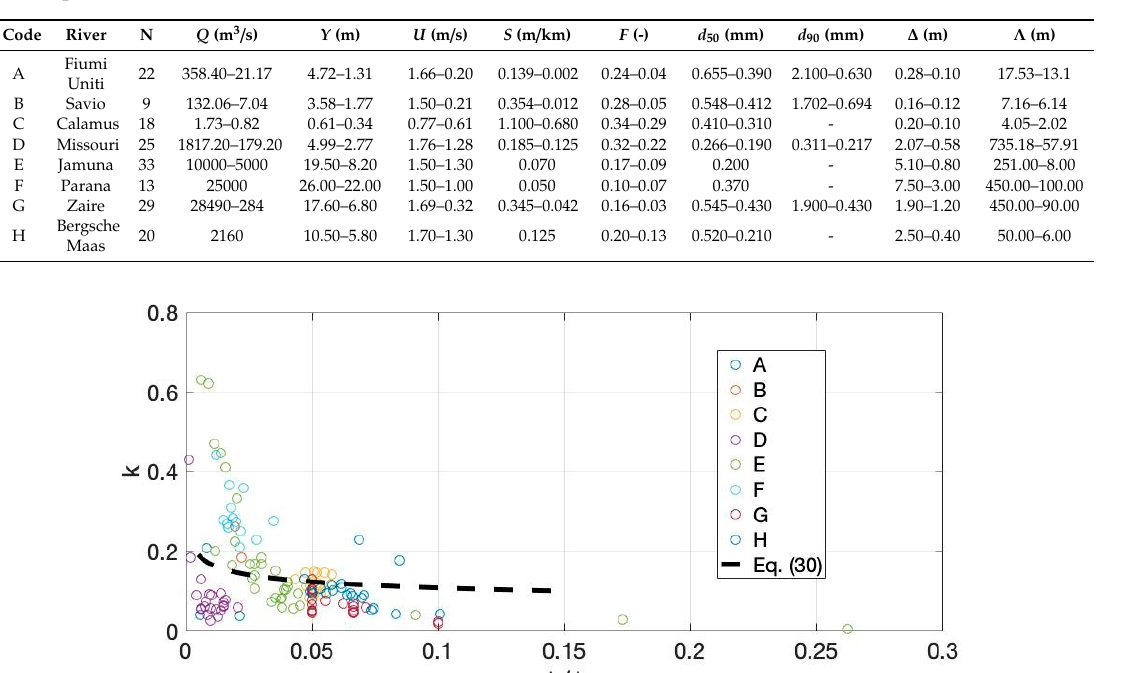
Table 1. Summary of field data used to determine empirical coe ffi cient κ (Equation (29)). Each column reports maximum and minimum value.